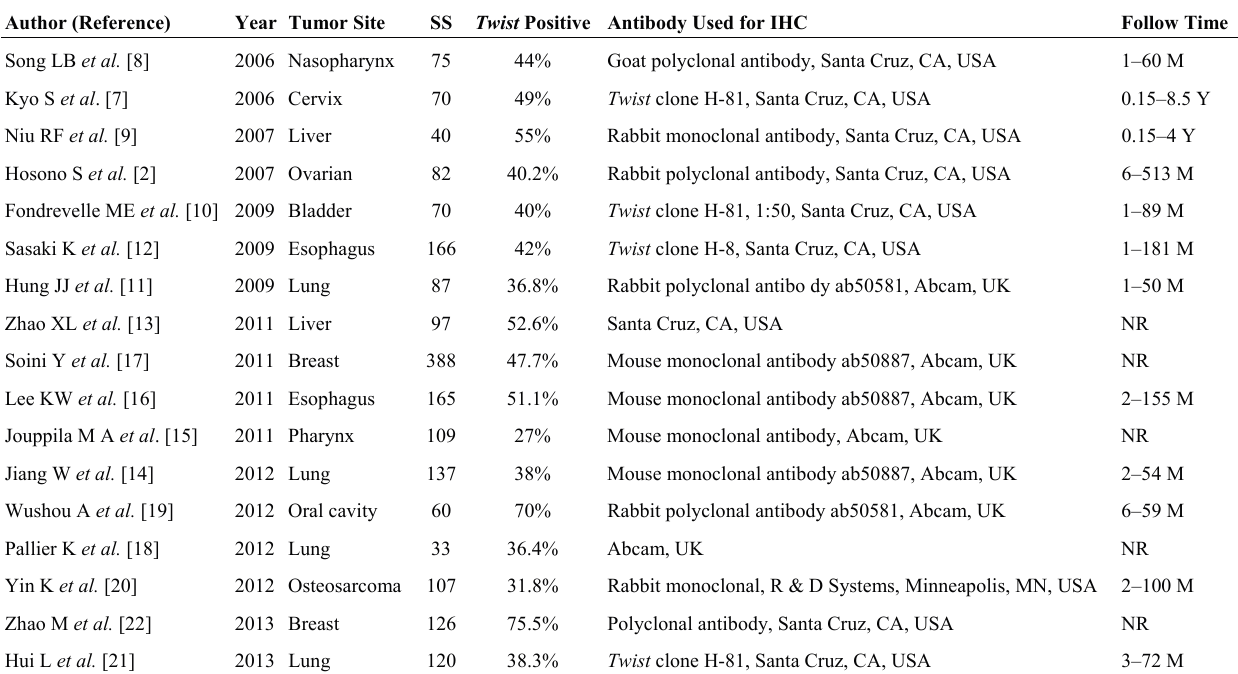
Table 1. Baseline characteristics of the selected studies.